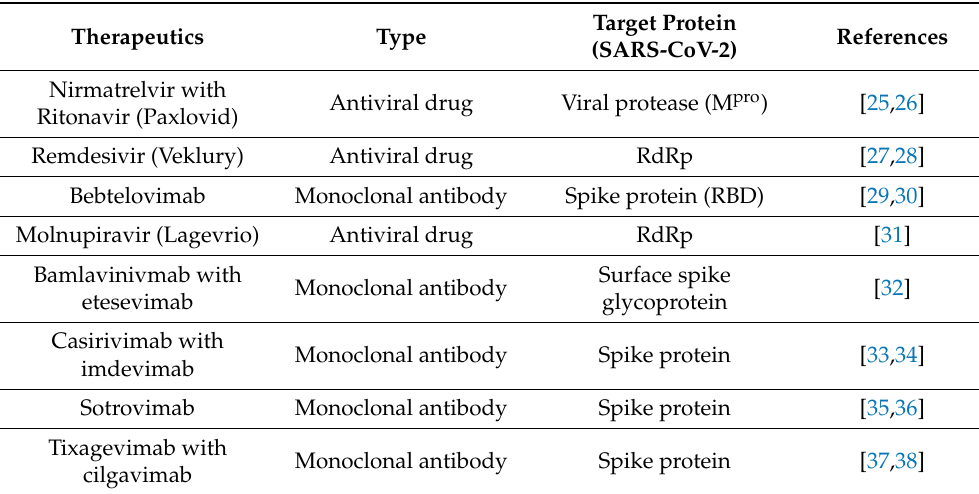
Table 1. Available drugs and non-vaccine therapeutics, with their target proteins, up to November 2022.